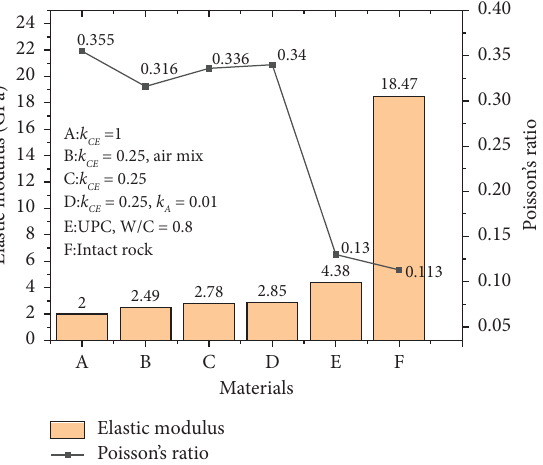
Figure 20: Elastic modulus and Poisson’s ratio of diferent materials. k A values and a CE of